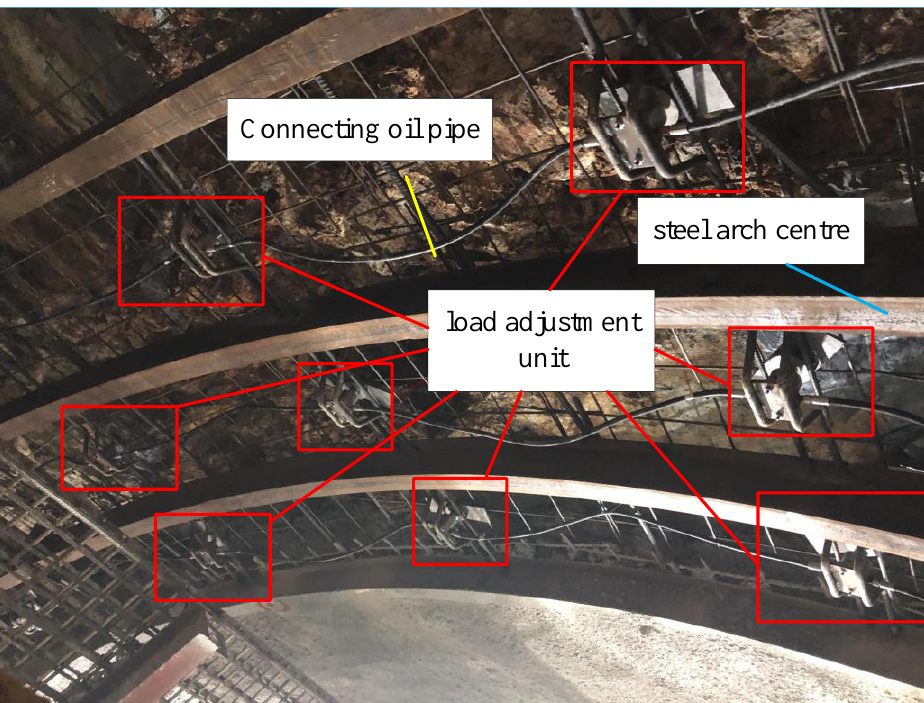
Figure 13. Field implementation effect of load adjustment unit.